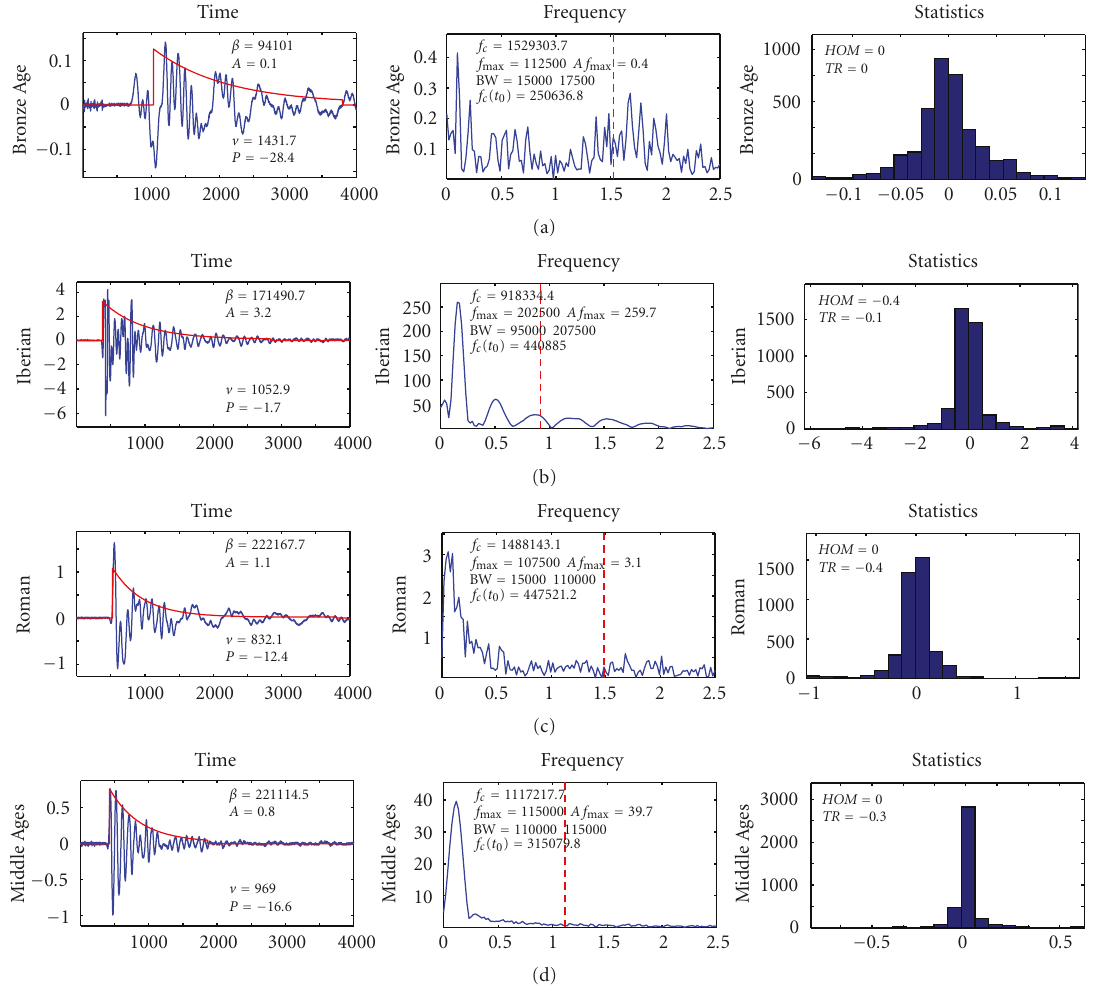
Figure 4: Some examples of time signals, spectra, histograms, and corresponding features extracted from ultrasonic signals for archaeolog- ical ceramic pieces from di ff erent periods. Units are: Time axis : sample number; Frequency axis : MHz; Statistics axis : bins of signal values; P (dB); v (m/s); f c , f max , BW, f c ( t 0 ) (Hz).